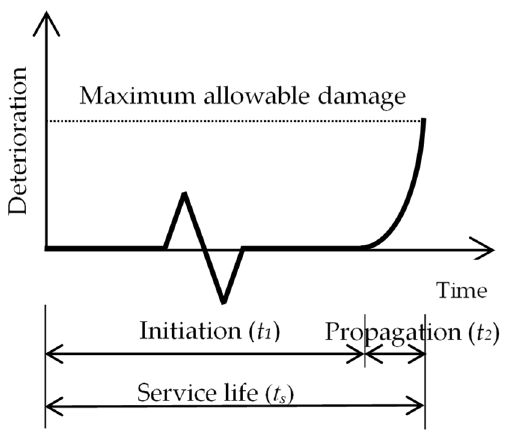
Figure 1. Phases in the service life of a RC structure.